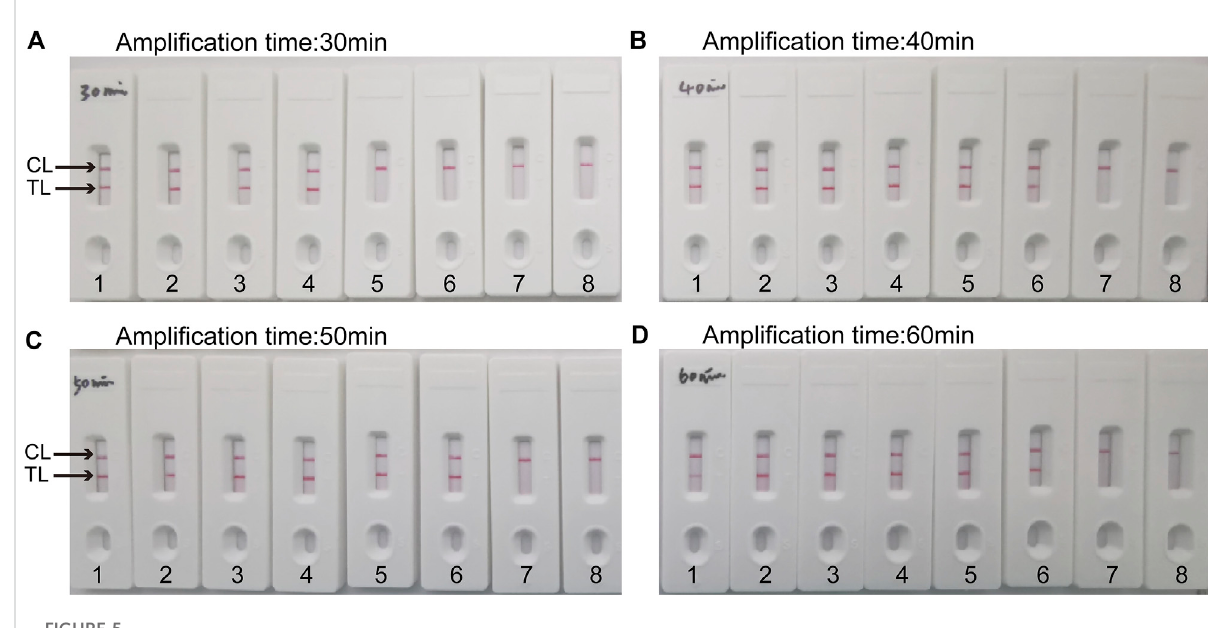
FIGURE 5 Optimal duration of time required for C . albicans -LAMP-LFB assay Four ampli fi cation times (A) , 30 min; (B) , 40 min; (C) , 50 min; (D) , 60 min) were evaluated at 64 ° C. Biosensors 1, 2, 3, 4, 5, 6, 7, and eight represent genomic DNA ( C.albicans (ATCC 10231)) levels of 10 ng, 10 pg, 1 pg, 100 fg, 10 fg, one fg and 100 ag target template per reaction and blank control (DW), respectively. The optimal time was showed when the ampli fi cation lasted for 40 min (B)